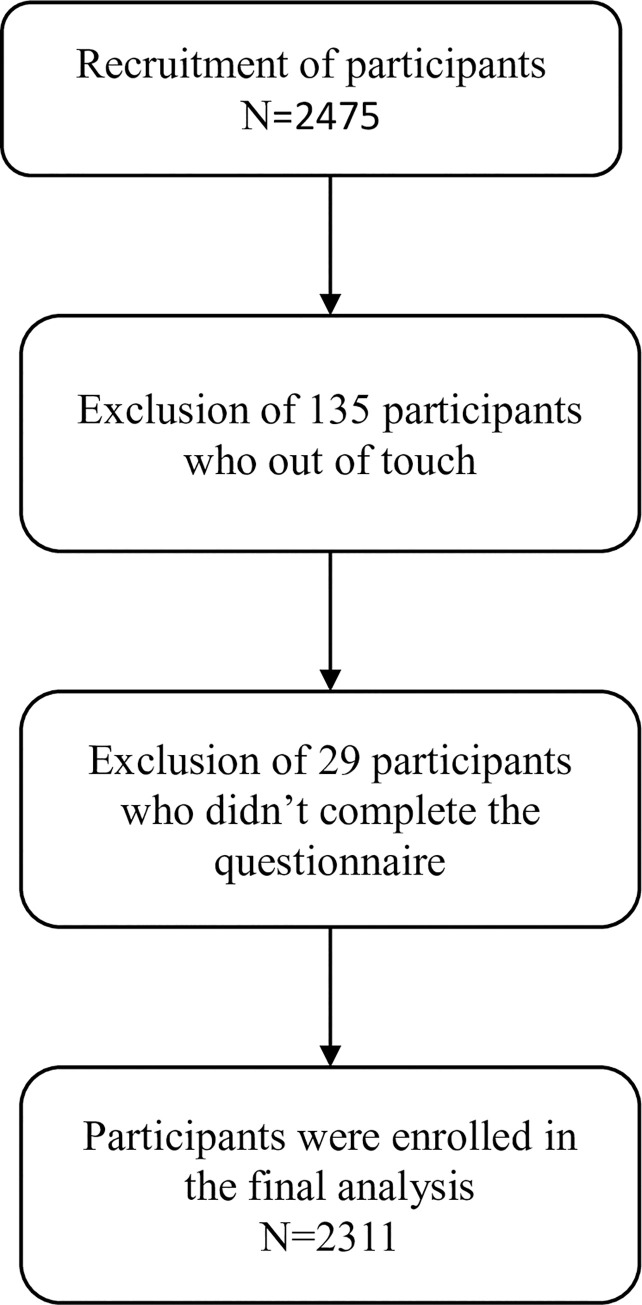
Flow chart of the study participants.